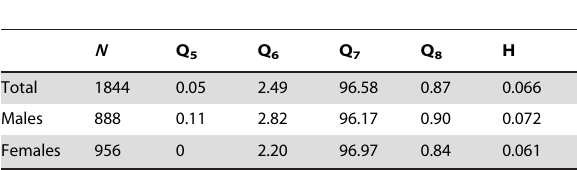
Table 1. Allele frequencies and observed heterozygosity (H) for the Clock gene in 922 adult barn swallows.